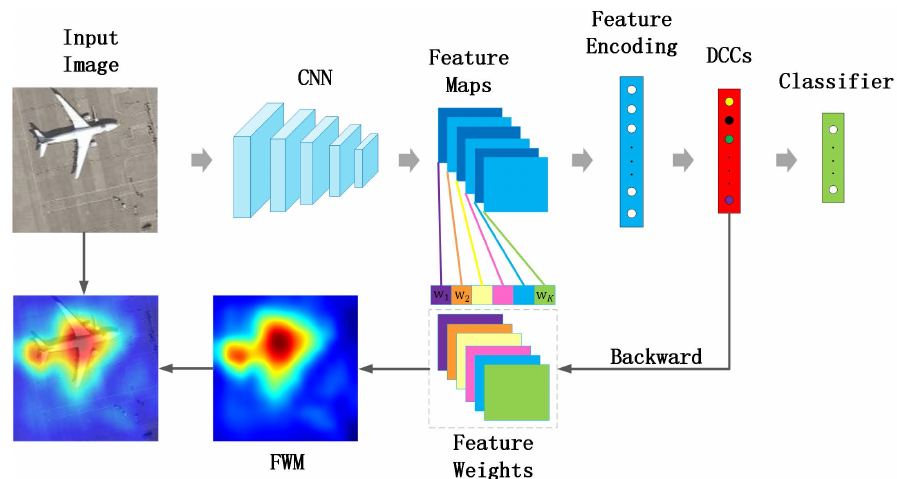
Figure 1. Framework of the DCC and FWM. An input image is mapped via the CNN to learn DCCs as image feature representations. The different colors of the DCC features indicate the different importance of each element in the feature